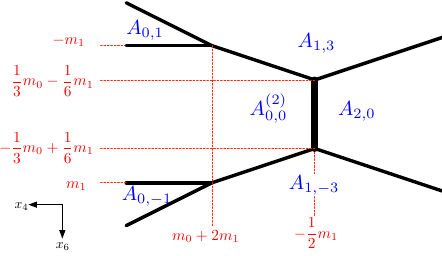
Figure 35. The regions for the largest A ( m ) Region 15 of the E 2 theory.